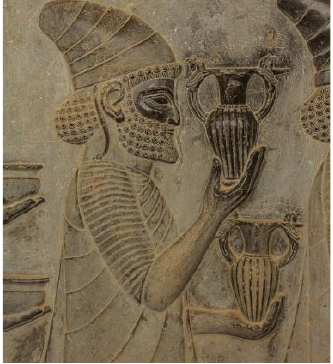
Figure 21. The relief of an Achaemenid man with a cup in his hand, Epochlimes, 2016